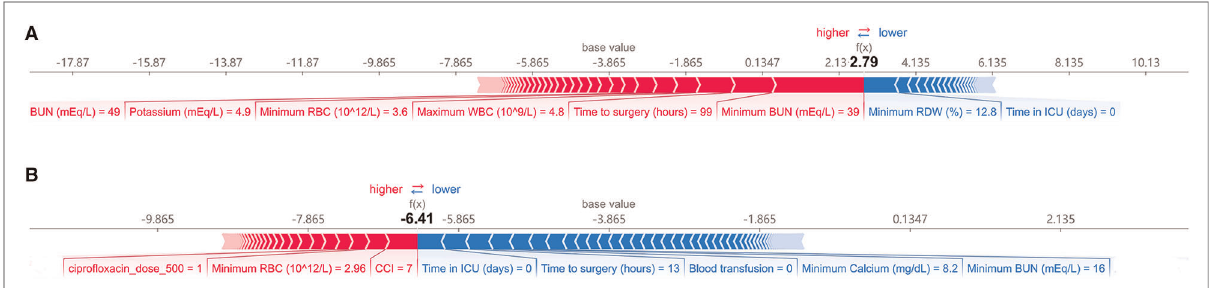
FIGURE 5 Explanation of the prediction results for speci fi c instances. The base value ( − 3.865) is the average value of the predictive model; the output values are the predicted AKI risks. The bars in red and blue represent risk factors and protective factors, respectively; longer bars mean greater feature importance. Here, these values are the model outputs before the SoftMax layer, and therefore, they are not equal to the fi nal predicted probabilities. This fi gure shows the explanation for a high-risk instance ( A ) and a low-risk instance ( B ). BUN, blood urea nitrogen; RBC, red blood cell count; WBC, white blood cell count; RDW, red cell distribution width; CCI, charlson comorbidity index; ICU, intensive care